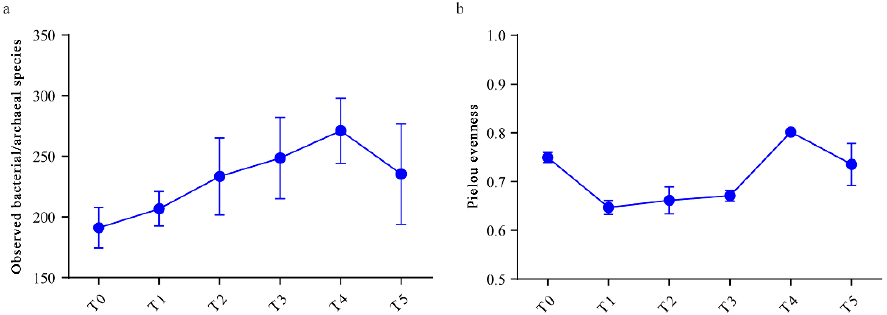
Figure 1. Dynamics of alpha diversity indices during seedling production. ( a ) Observed bacterial/archaeal species. ( b ) Pielou’s evenness.